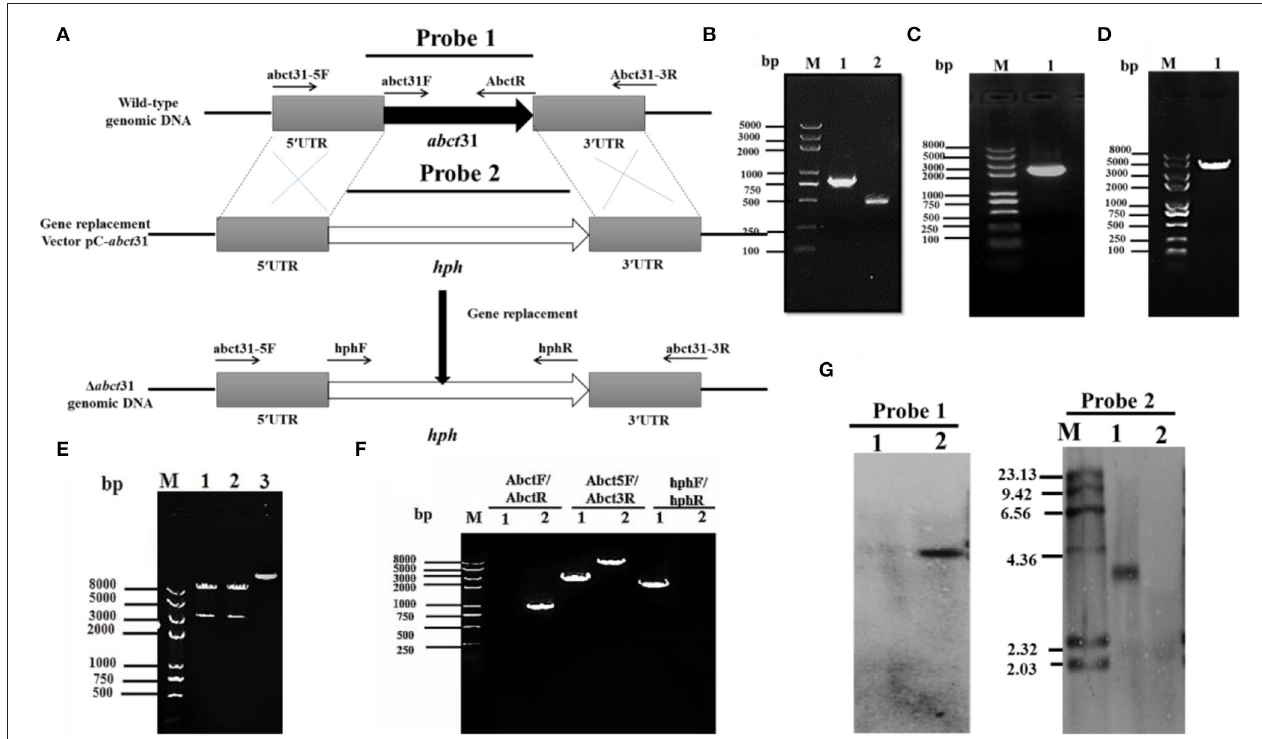
FIGURE 6 | Construction and verification of 1 abct 31 strain. (A) Pictorial presentation for the homologous recombination approach to create abct 31 disruption strains. (B) M: Trans 2k II Marker; Lane1: PCR product of 5’ franking region (770 bp); Lane 2: PCR product of 3’ franking (434 bp). (C) M: Trans 2k plus II Marker; Lane 1: hph (2,137 bp). (D) M: Trans 2k plus II Marker; Lane 1: PCR product of recombinant fragment of 5’UTR, hph and 3’UTR (3341 bp). (E) M: Trans 2k plus II Marker; Lane1: Restriction enzyme digestion analysis of vector pC- abct 31 ( KpnI / HindIII ). (F) Validation of abct 31 homologous recombination events. M: Trans 2k plus II Marker; Lane 1, the abct 31 strain; Lane 2, the wild-type strain (M7). Different distinct bands were obtained by PCR amplification for selected pair of primer. (G) Southern hybridization analysis. Lane 1, Xba1 digested genomic DNA of 1 abct 31; lane 2, Xba1 digested genomic DNA of M7 respectively; M: λ DNA/ HindIII marker; Probe 1: abct 31 gene; Probe 2: hph gene.